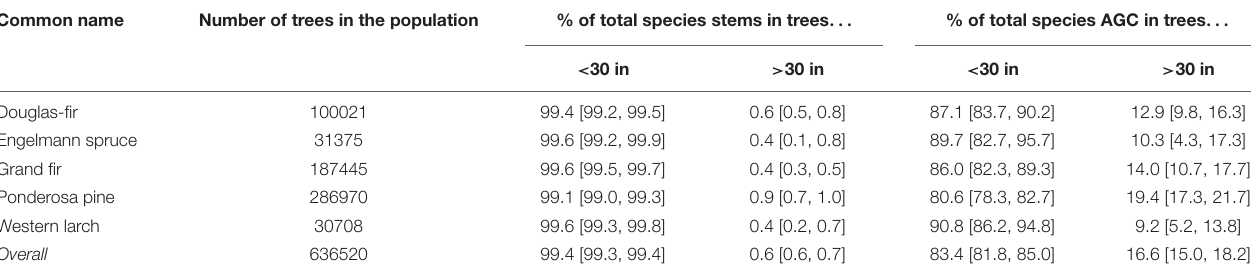
TABLE 4 | Percentage of all tree stems and total aboveground carbon (AGC) occurring in trees above and below the 30 in diameter threshold based on measurements from USFS inventory plots located in the six eastside national